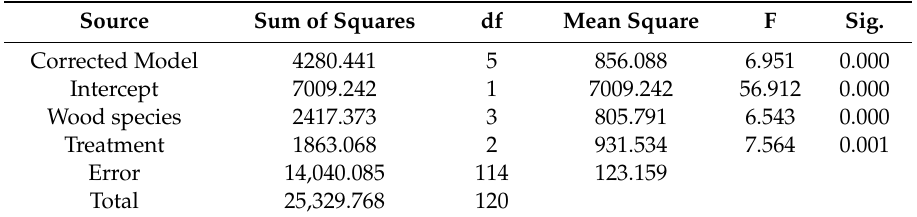
Table 3. Variance analysis of percent weight loss.